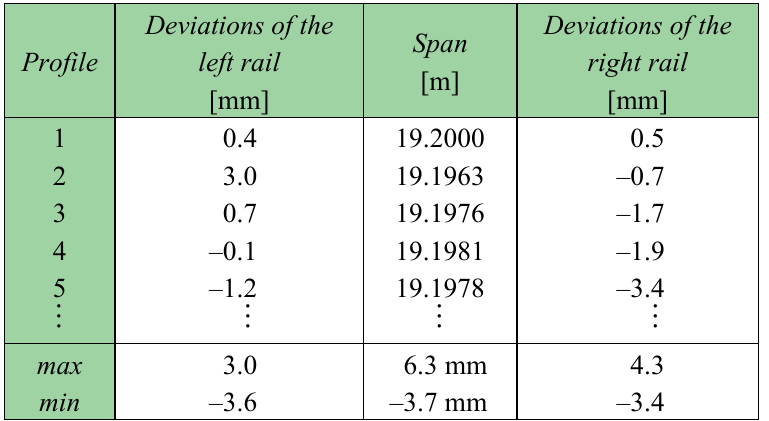
Table 5. Representation of numerical results in horizontal sense.